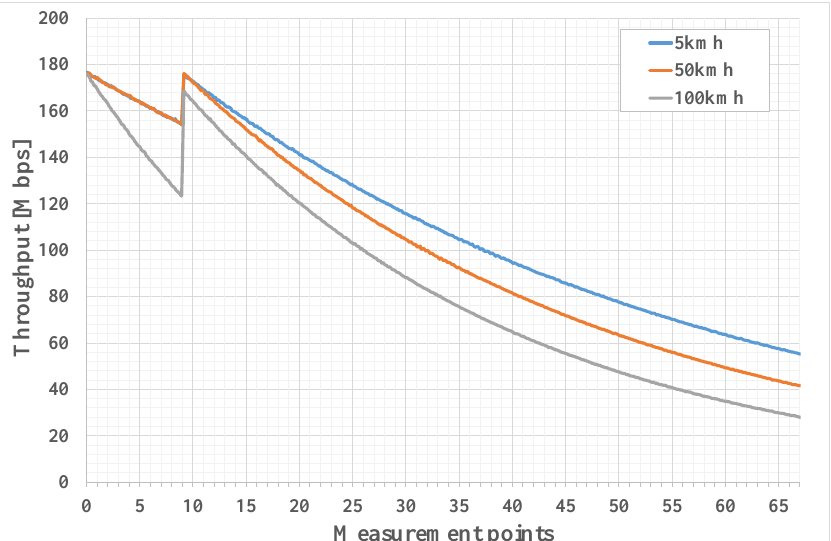
Figure 9. Throughput for different UE velocities. This figure shows the throughput plotted against measurement points from Figure 7. The blue line corresponds to the pedestrian UE walking along the trajectory, the red line corresponds to the UE riding a scooter, and the gray line corresponds to the UE riding a car with a velocity comparable to that of the UAV.